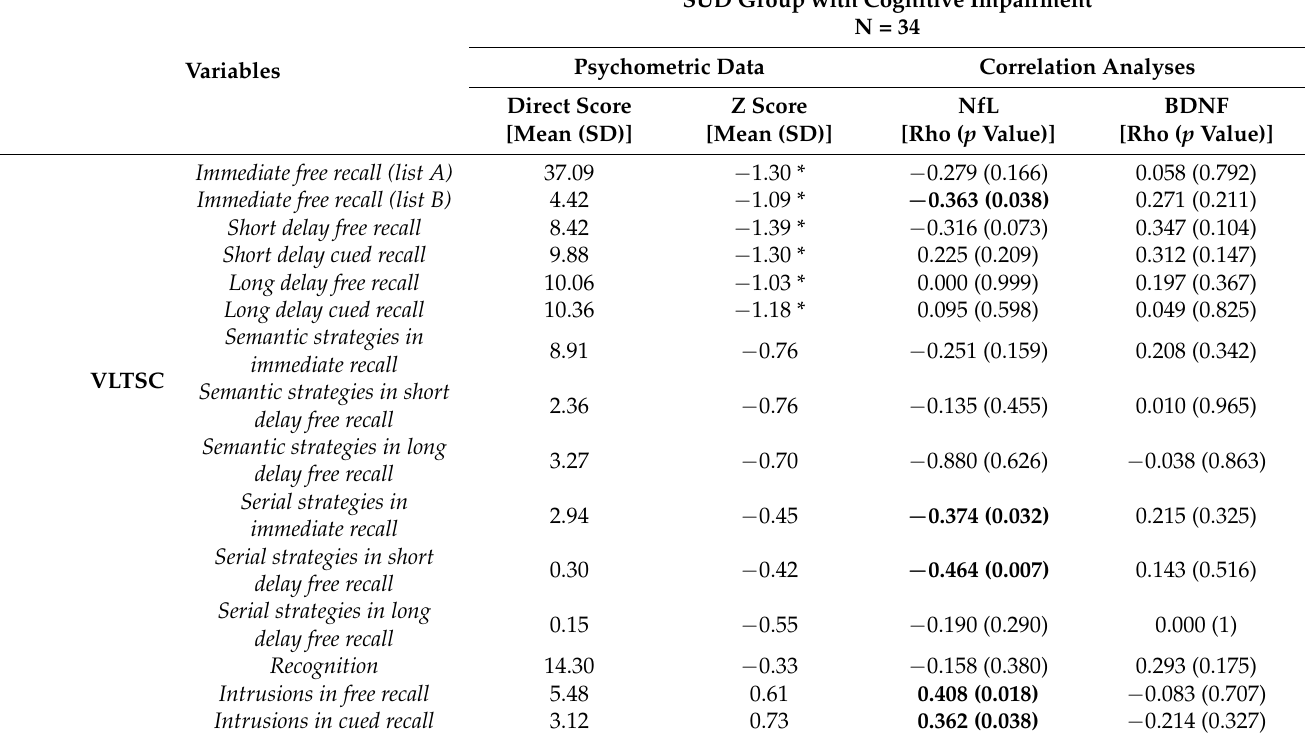
Table 3. Neuropsychological psychometric values and their correlations with plasma concentrations of NfL and BDNF in SUD